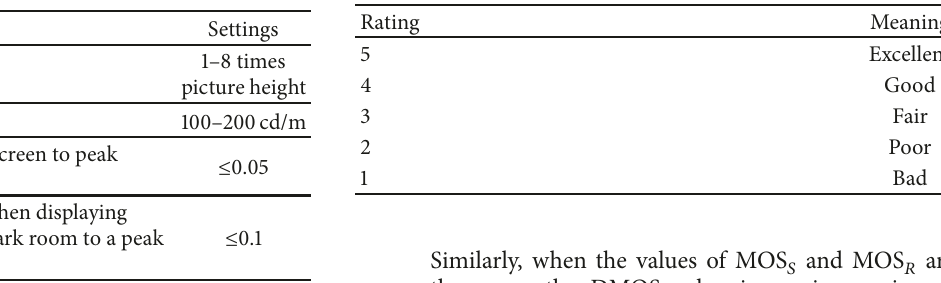
Table 3: Summary of viewing conditions. Table 4: MOS